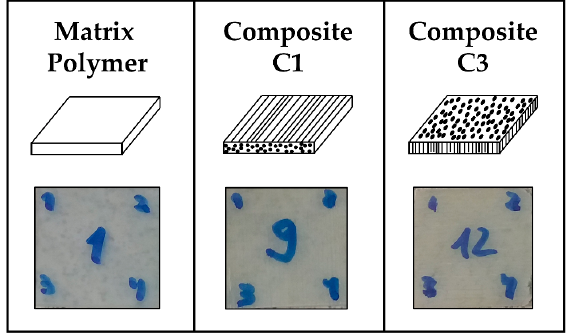
Figure 1. Matrix polymer and composite plates used for swelling measurements.